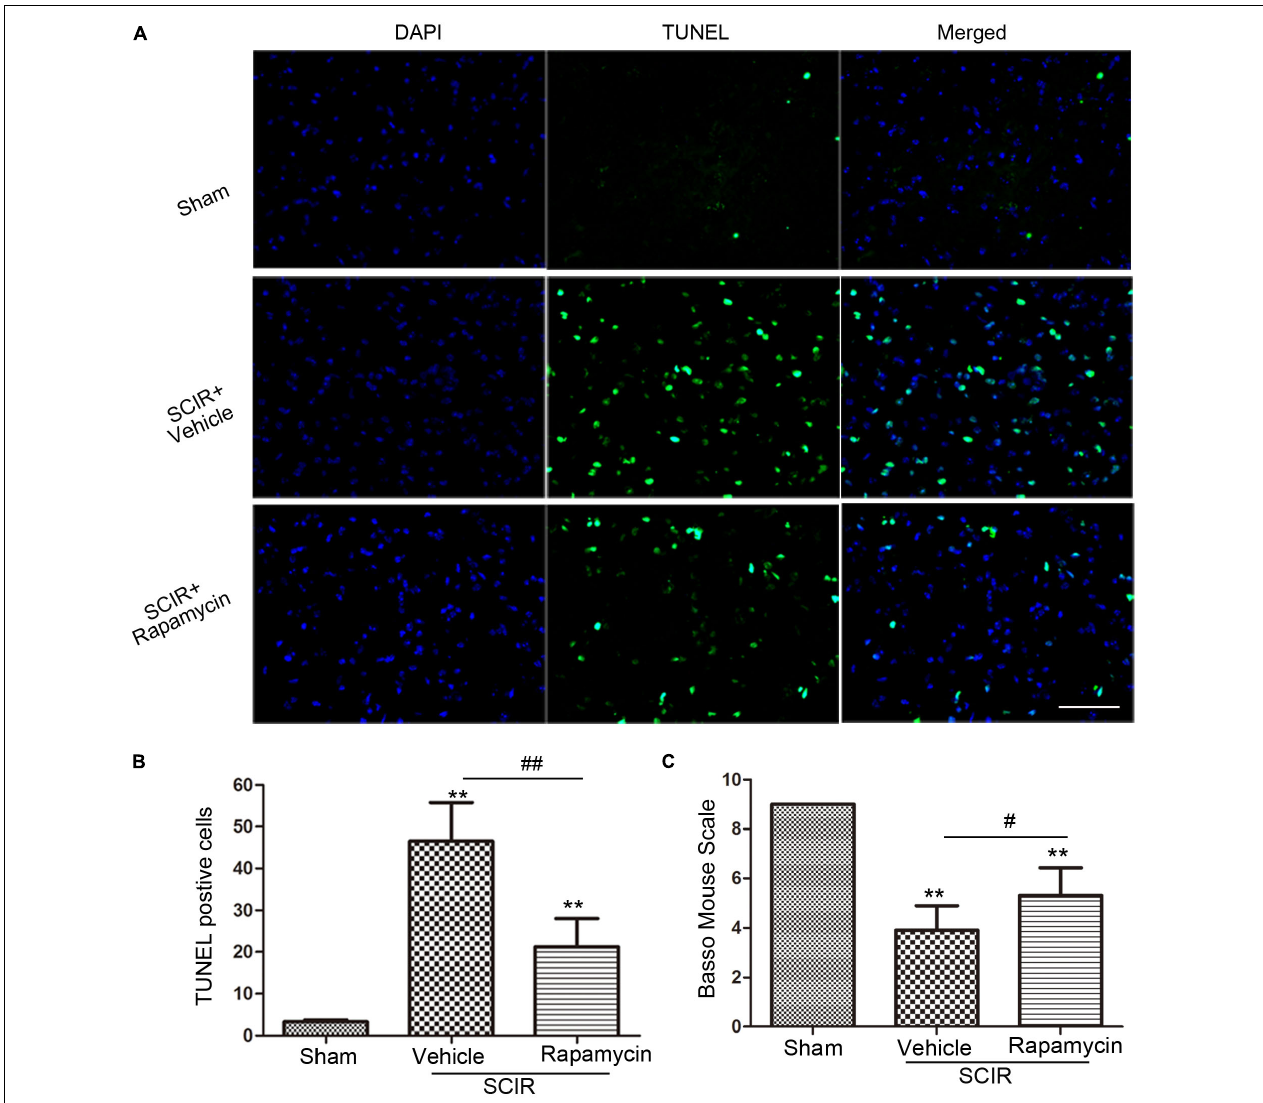
FIGURE 4 | Rapamycin attenuated spinal cord ischemia-reperfusion induced apoptosis. (A) . These cells were stained with TUNEL and DAPI. The merged picture shows colocolization of apoptotic and nuclear markers. Scare bar = 50 µ m. (B) .The bar graph shows rapamycin treatment rescued neurons from apoptosis at 24 h after SCIR. Data were shown as mean ± SD, n = 6. The numbers of apoptotic cells were counted in three sections of ischemic spinal cord. ∗ p < 0.05, ∗∗ p < 0.01 vs. Sham; # p < 0.05, ## p < 0.01. (C) Bar graphs show the rapamycin-treated mice have significantly higher BMS scores than the vehicle-treated mice at 24 h after injury. Data were shown as mean ± SD, n = 16. ∗ p < 0.05, ∗∗ p < 0.01 vs. Sham; # p < 0.05, ## p <